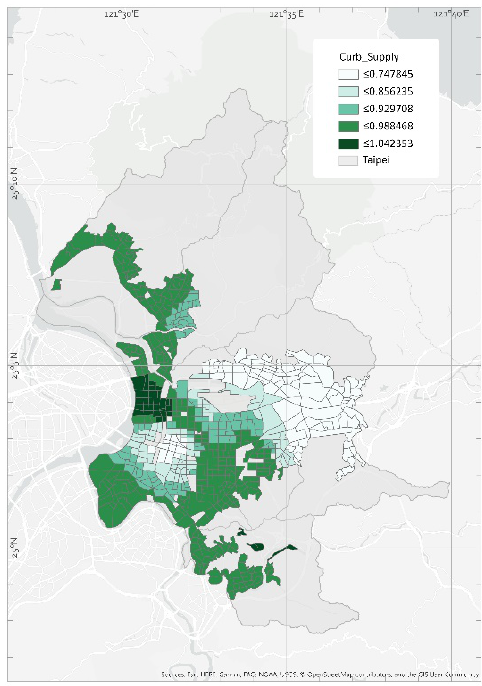
Figure 3. Coefficient of Curb Parking Space Supply